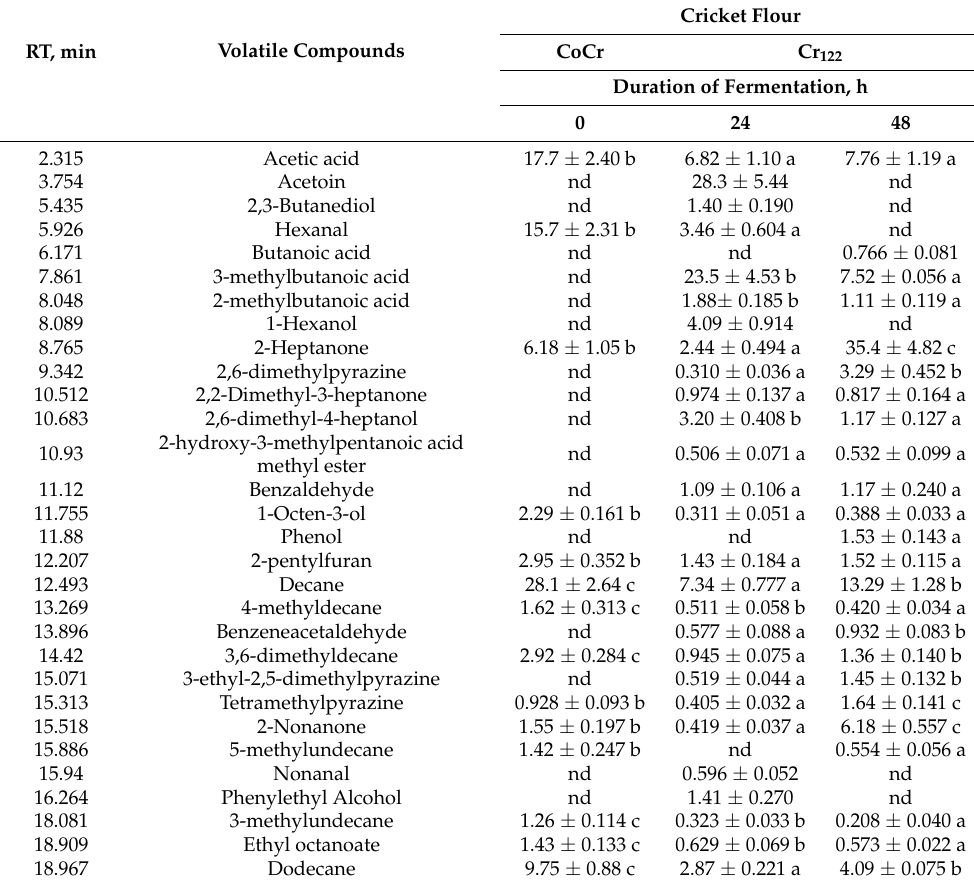
Table 5. Volatile compounds in non-treated and fermented cricket flours (only volatile compounds whose content in the cricket flour samples was in at least one sample >1% are